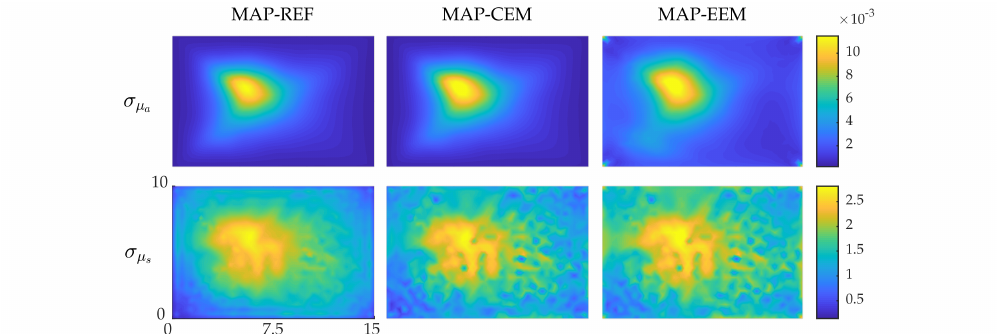
Figure 1. MAP estimates of the simulations with smooth inclusions. True optical parameters ( first column ), MAP-REF estimates ( second column ), MAP-CEM estimates ( third column ) and MAP-EEM estimates ( fourth column ). First row presents the absorption coefficients and second row the scattering coefficients. In the first column images, solid line indicates the cross-section in which the credibility intervals are plotted, and × and (cid:52) indicate the points where the marginal densities are plotted. The units of axes are in mm and colorbars in mm − 1 .